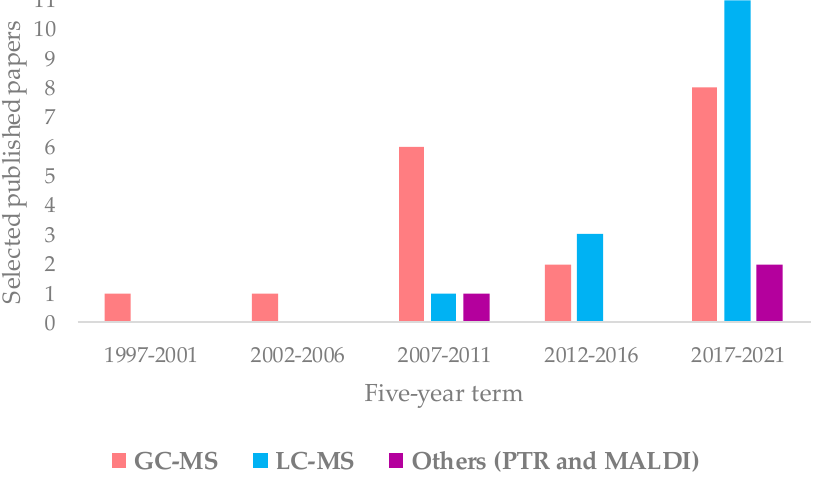
Figure 7. Evolution over five-year period of molecular-fingerprint and chromatography MS techniques reported in here selected studies.